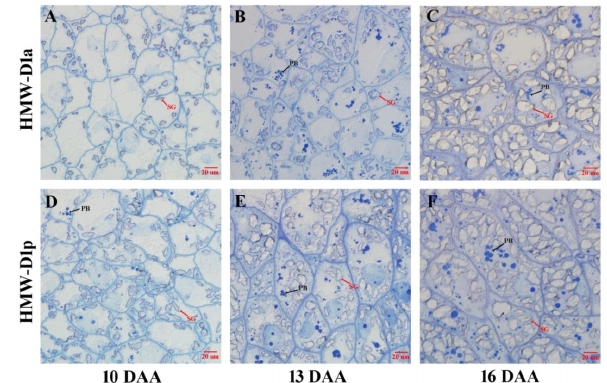
Figure 3. Cytological observations of wheat endosperm. ( A – F ) represents the endosperm at 10, 13, and 16 days after anthesis (DAA) in HMW-D1a ( A–C ) and HMW-D1p ( D–F ) with the scale bar of 20 µ m. Red arrows indicate starch granules (SG) and black arrows indicate protein body (PB). 2.4. Changes in GS and GPT Activities and Levels of Amino Acids in Flag Leaves and Grains during Grain Development